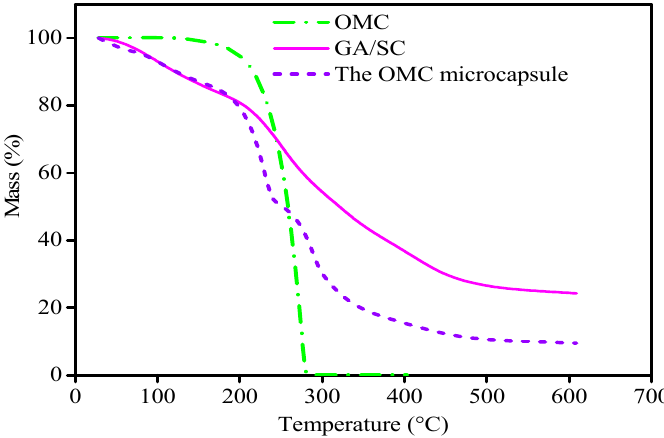
Figure 8. Thermal behavior of OMC, SC/GA, and the OMC microcapsule.